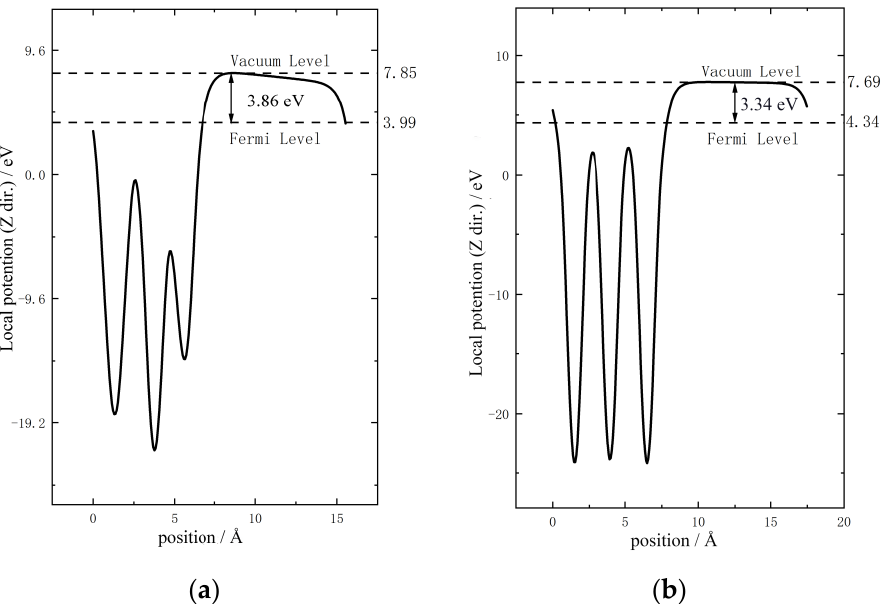
Figure 7. Local electrostatic potential energy in the Z direction of different systems (Pu-Al system ( a ) δ -Pu system ( b )).